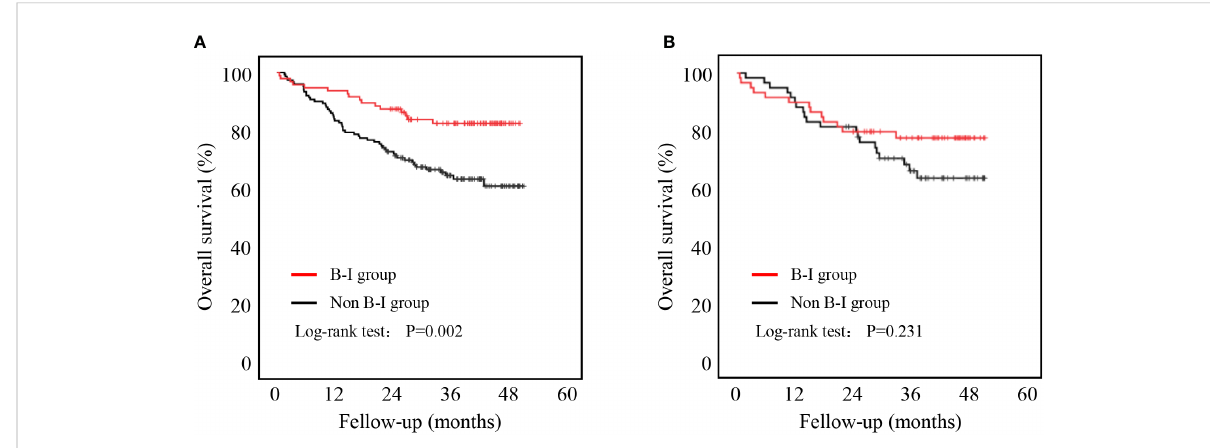
FIGURE 3 Five-year overall survival curve calculated using the Kaplan-Meier method comparing B-I and non-B-1. (A) Before PSM; (B) After